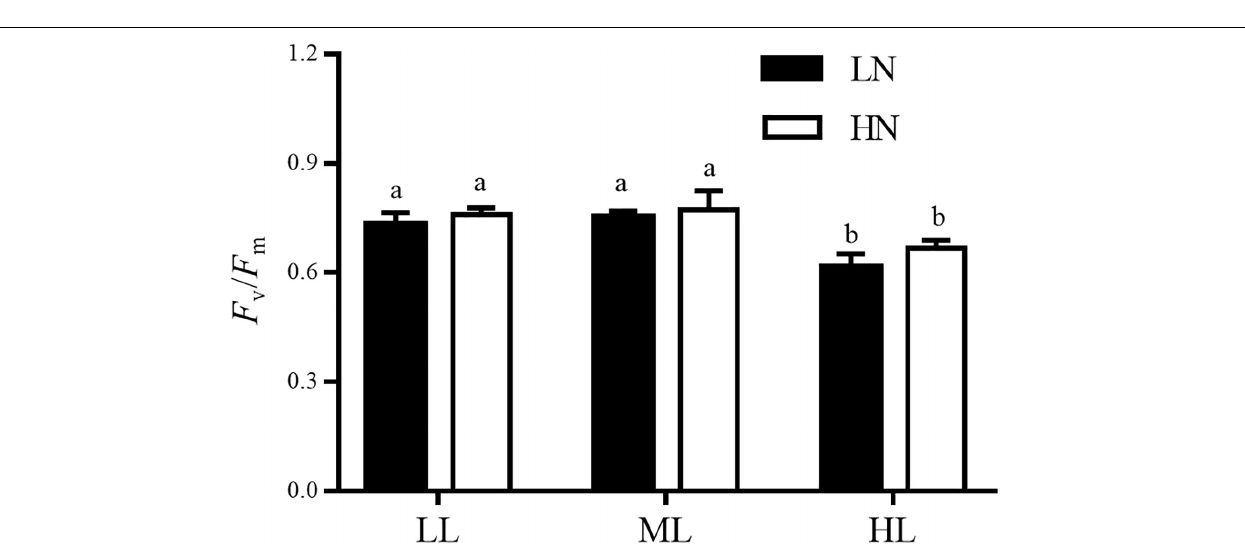
FIGURE 2 | Dark respiration rates of S. muticum grown at different light and nitrogen levels for 12 days. Significant ( P < 0.05) differences among the treatments are indicated by different lowercase letters. Vertical bars represent ± SD for the means of three samples.